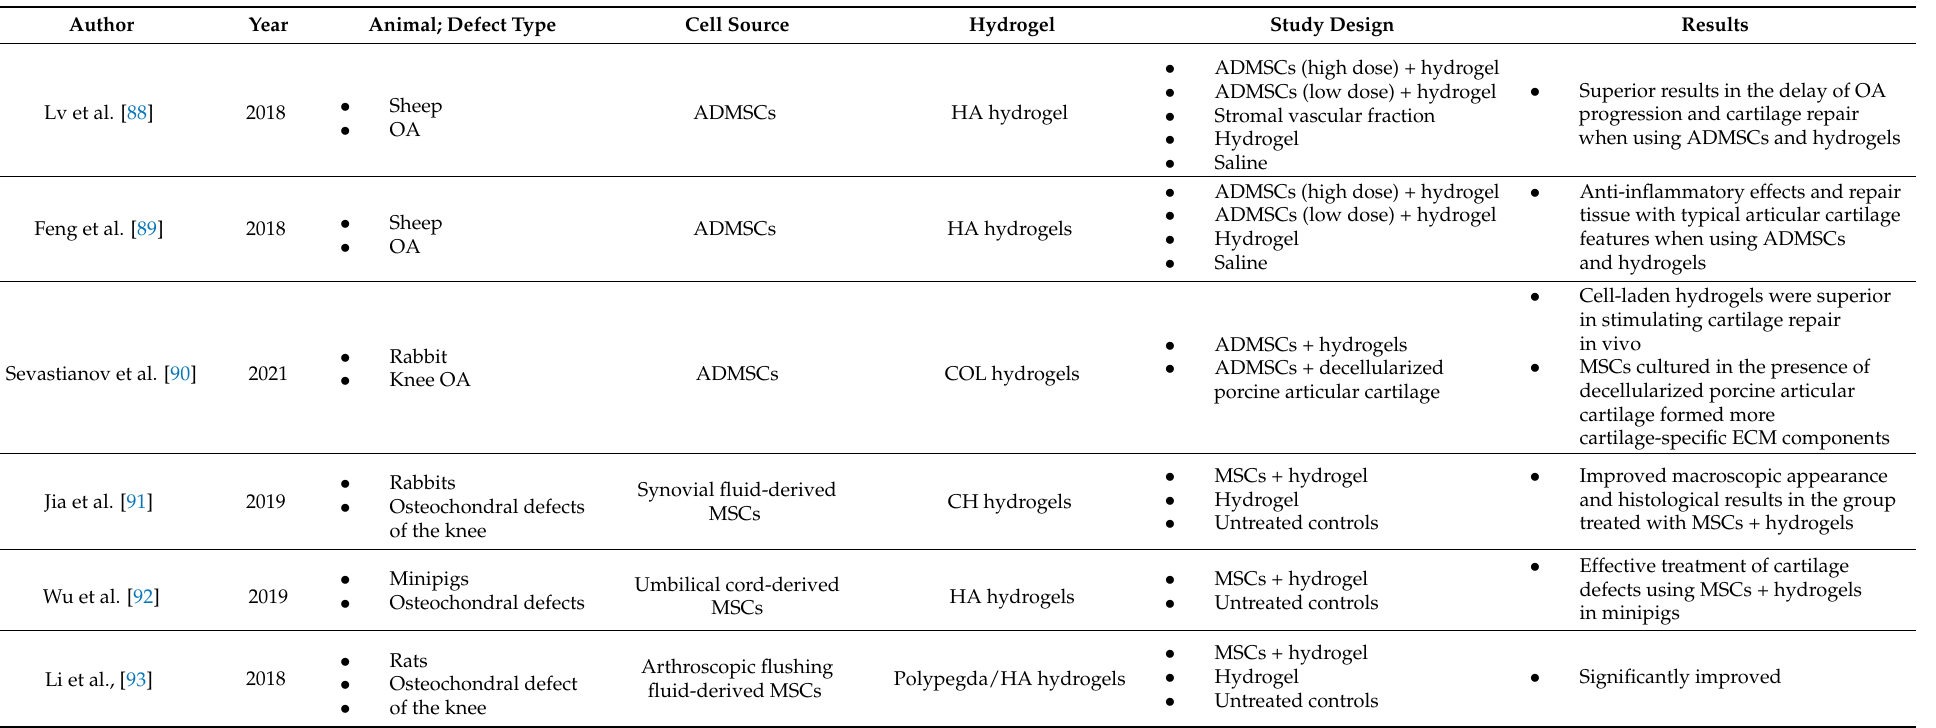
Table 4. Preclinical studies examining the use of different combinations of MSC-subpopulations and hydrogels for cartilage